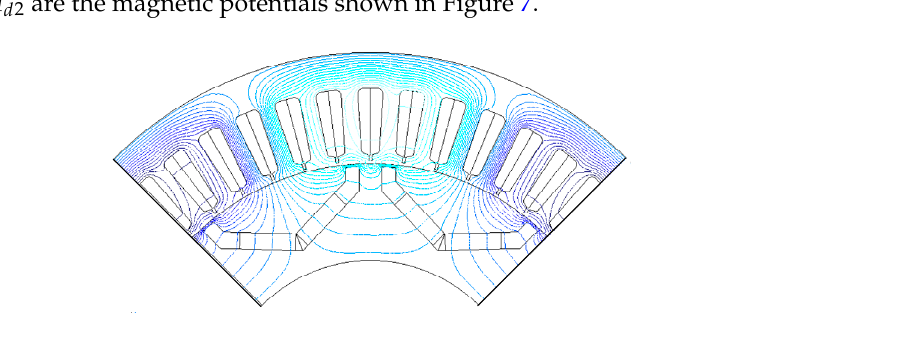
Figure 7. Flux line distribution in the d ‐ axis.